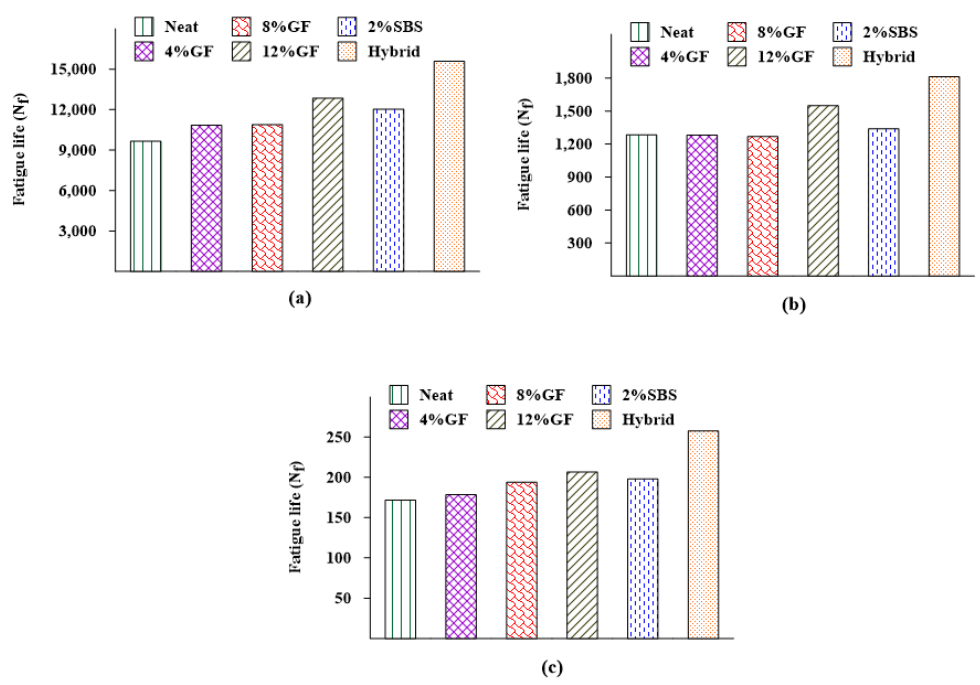
Figure 7. Additives effects on the N f at ( a ) 10 ◦ C, ( b ) 20 ◦ C, and ( c ) 30 ◦ C.